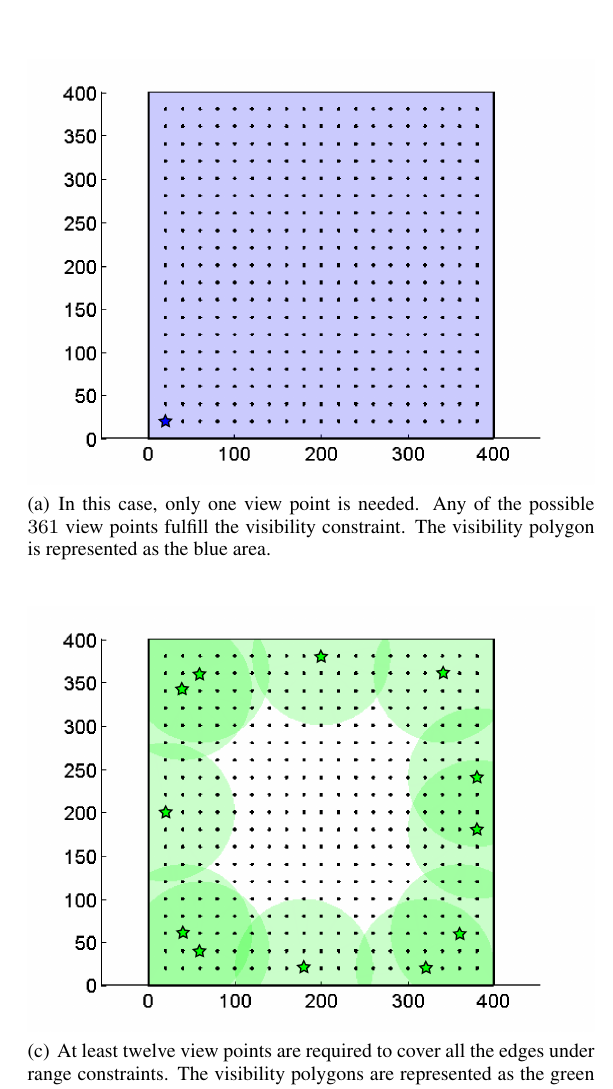
areas. Figure 3: Visibility coverage of simple room. 361 view points are used in the scene, depicted as black dots. Possible view points that fulfill the visibility constraints are depicted as stars, with their visibility coverage area. The darker the visibility area, the more view points